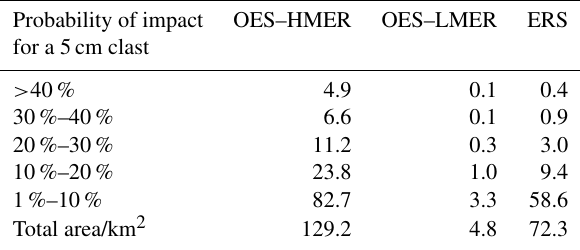
Table 2. Area within each probability category in the hazard zone (in km 2 ) for the OES–HMER, OES–LMER and ERS. The hazard zone is the area with a probability of impact from 5cm clast ≥ 1%.